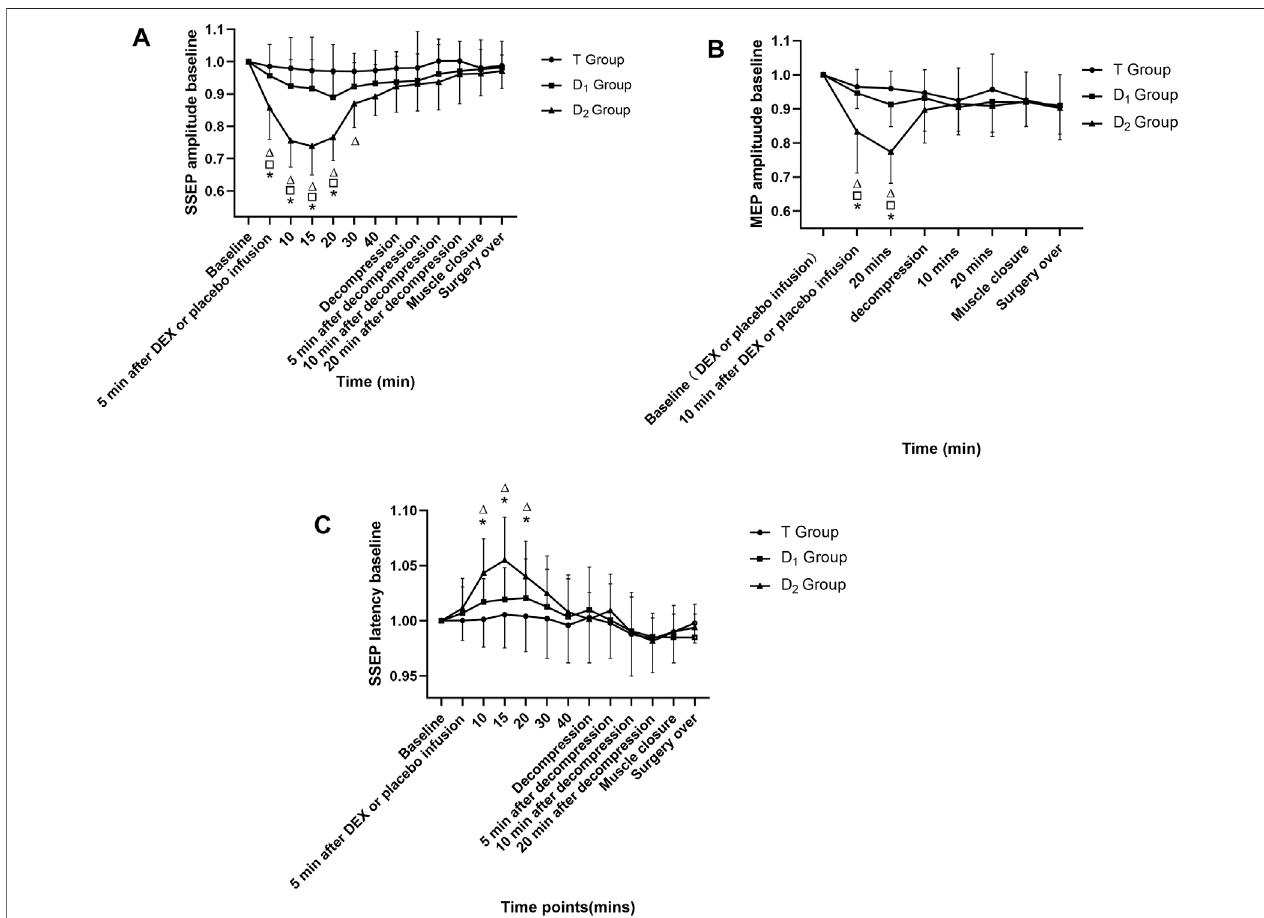
FIGURE 2 | Time course of SSEP and MEP amplitude variability, as well as SSEP latency variability in the three groups. △ Compared with baseline value (after muscleincision,butbeforedexmedetomidineorplaceboinfusion)atcorrespondingtimepoints, p ＜ 0.05;comparedwiththeD 1 groupatcorrespondingtimepoints, p ＜ 0.05; * compared with the T group at corresponding time points, p ＜ 0.05. DEX: dexmedetomidine; the T group: propofol- and remifentanil-based total intravenous anesthesia group; the D 1 group: TIVA combined with dexmedetomidineat aconstantinfusion rate; the D 2 group: TIVA combined with dexmedetomidine delivered by a loading dose and then by a constant infusion rate.